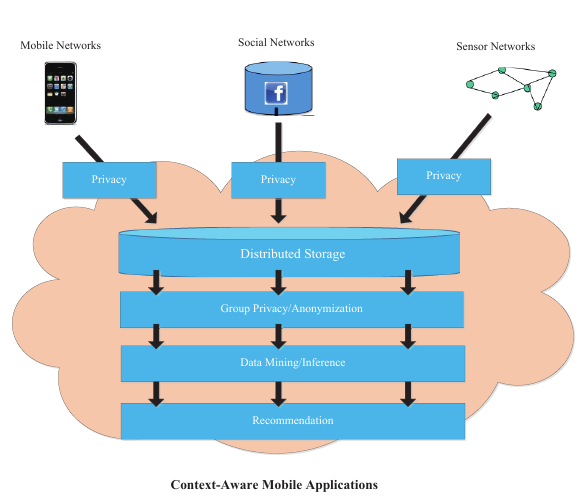
Figure 5. Privacy, Data Mining, and Recommendation Services in the Context-Aware Mobile Social